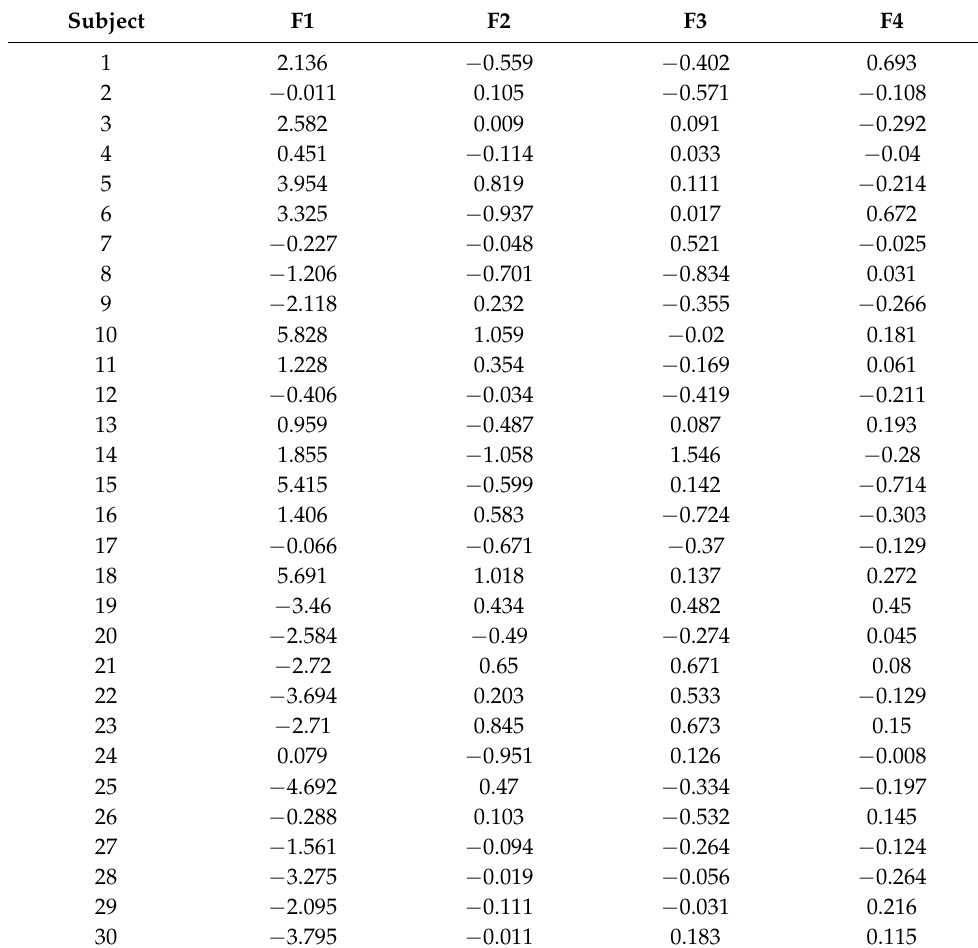
Table 6. Contribution of each mode to the reconstruction of hand forces of